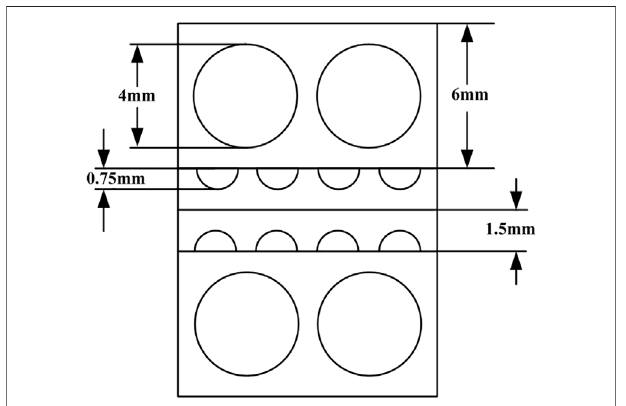
FIGURE 1 | Internal structure of the PCHE.